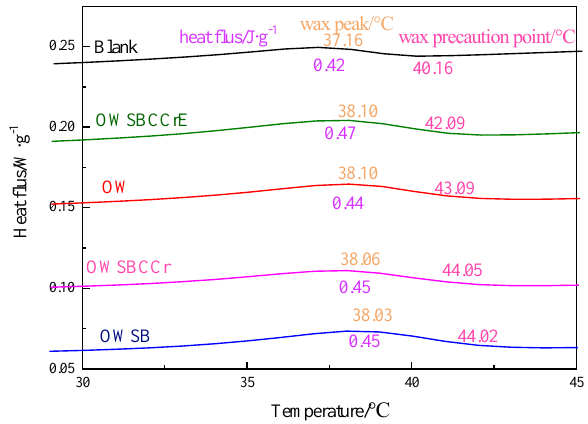
Figure 12. The DSC of heavy oil that has reacted under different conditions.